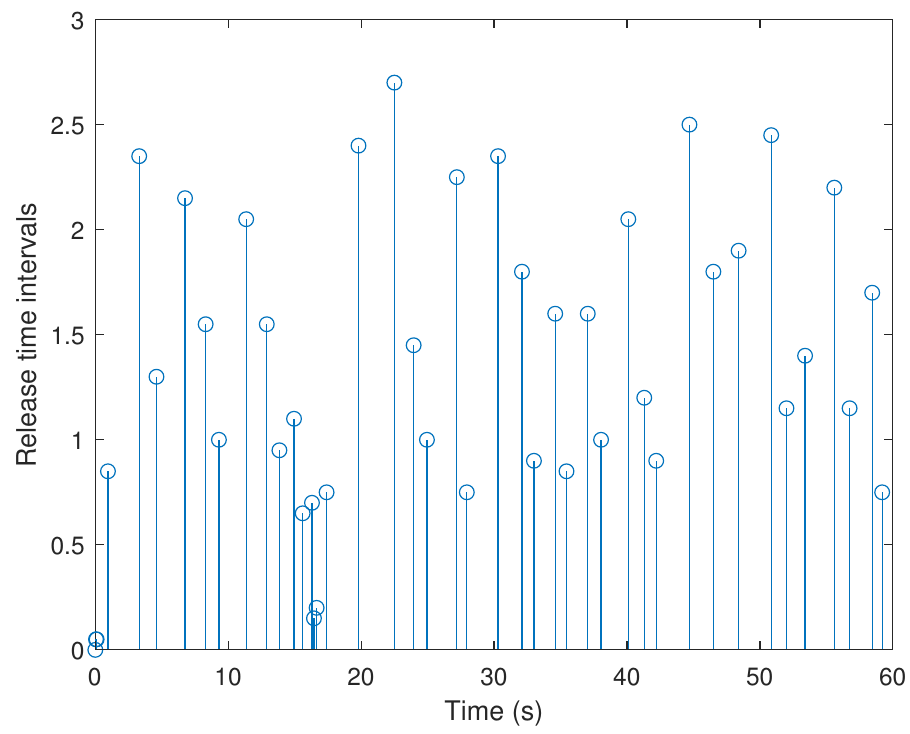
Figure 9. Release instants and release intervals with ¯ σ = 0.7.